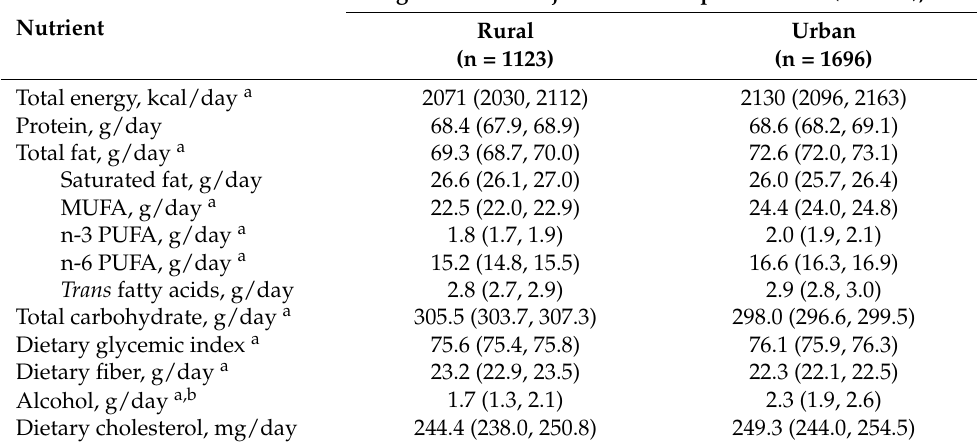
Table 2. Comparison of energy-adjusted nutrient intakes and type of cooking oil used by elderly Costa Ricans living in rural and urban